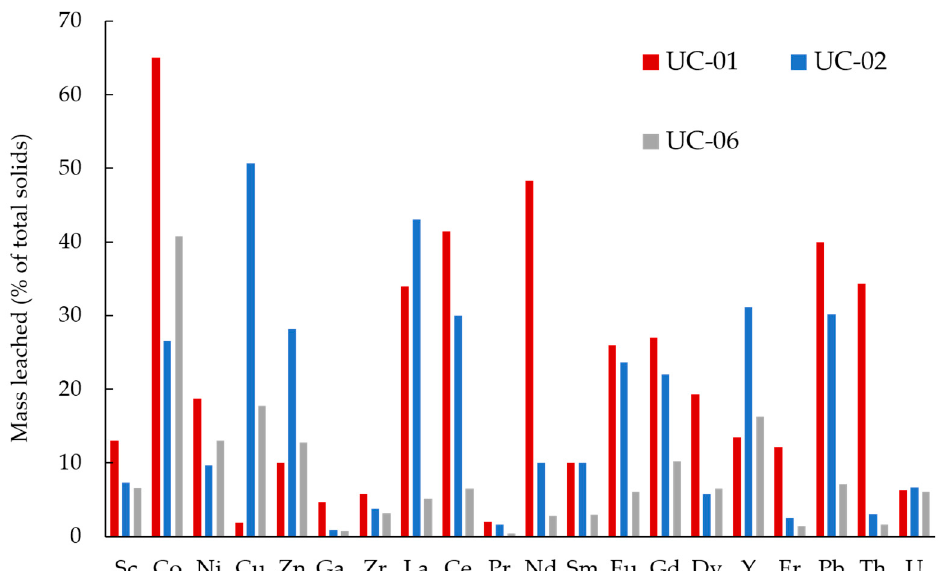
Figure 4. Concentration of REE and other trace metals leached from underclay with 0.1 M citrate + NaCl. Values are reported as the percent of total solids leached from the sample.